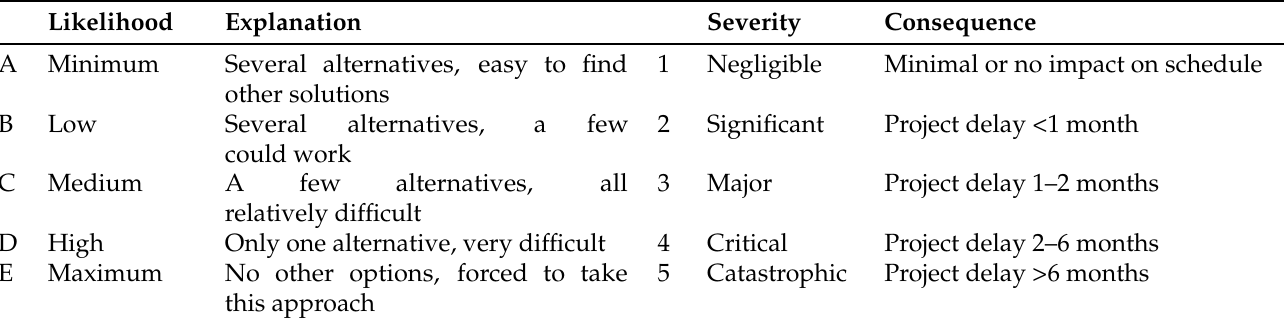
Table 5. Evaluated risk index criteria, adapted from the ECSS.